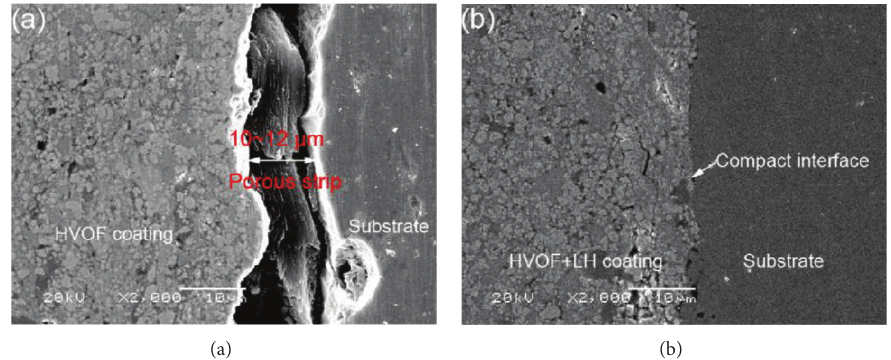
Figure 1: (a) Porous coating and interface between coating and substrate; (b) interface compacted by laser heating.